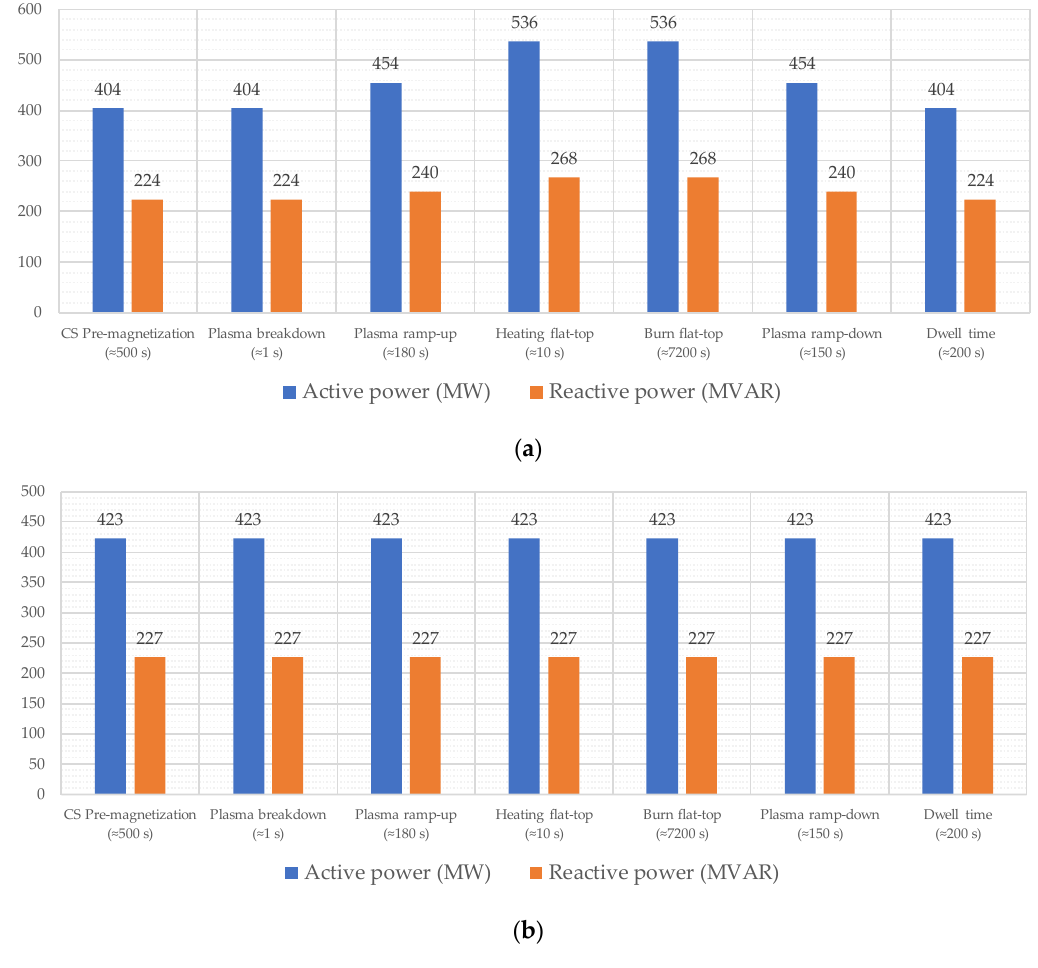
Figure 7. Nominal SSEN active and reactive powers in each plasma phase, considering the two di ff erent PHTS-PCS options: ( a ) HCPB and ( b )